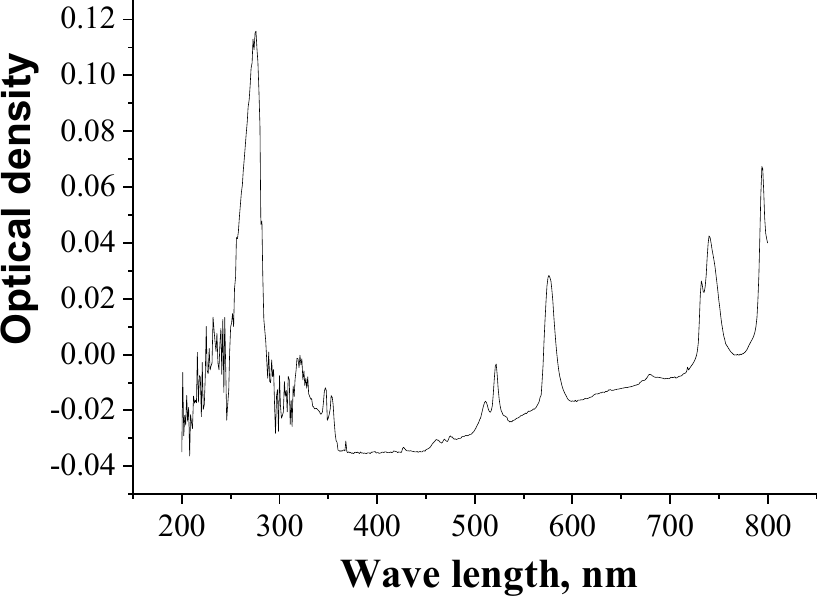
Figure 10. Specific absorption spectrum of Nd(III) solution in HNO 3 of 1 mol/L.